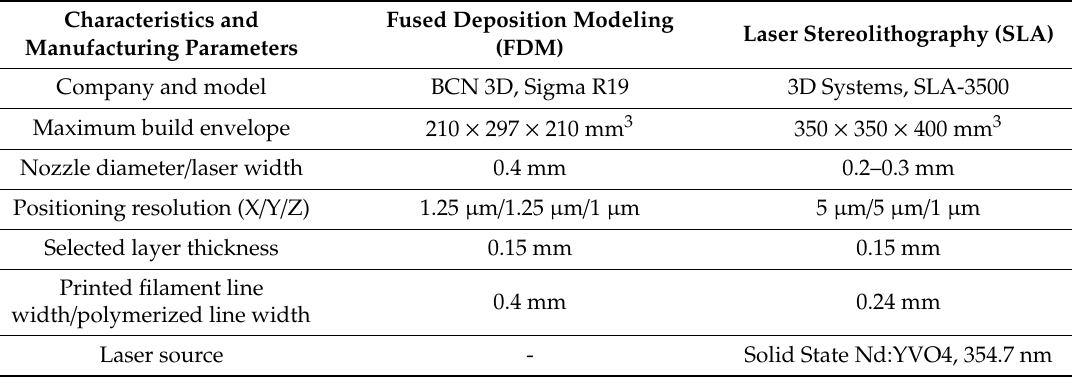
Table 1. Characteristics of the additive manufacturing technologies according to the manufacturers’ data sheets and manufacturing parameters employed for this study.